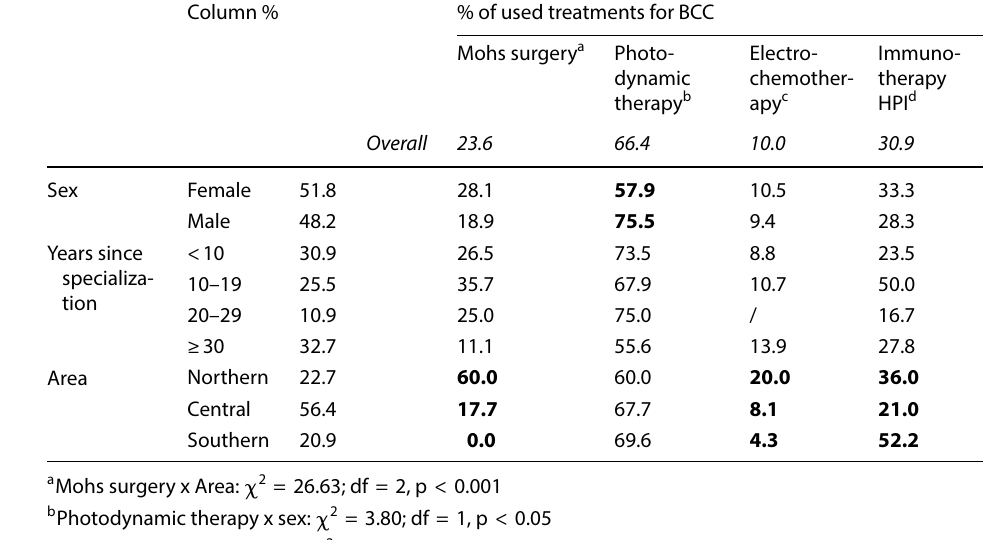
Table 2 Description of the sample and relationship between sociodemographic features and therapeutic choices for SCC (N.110)